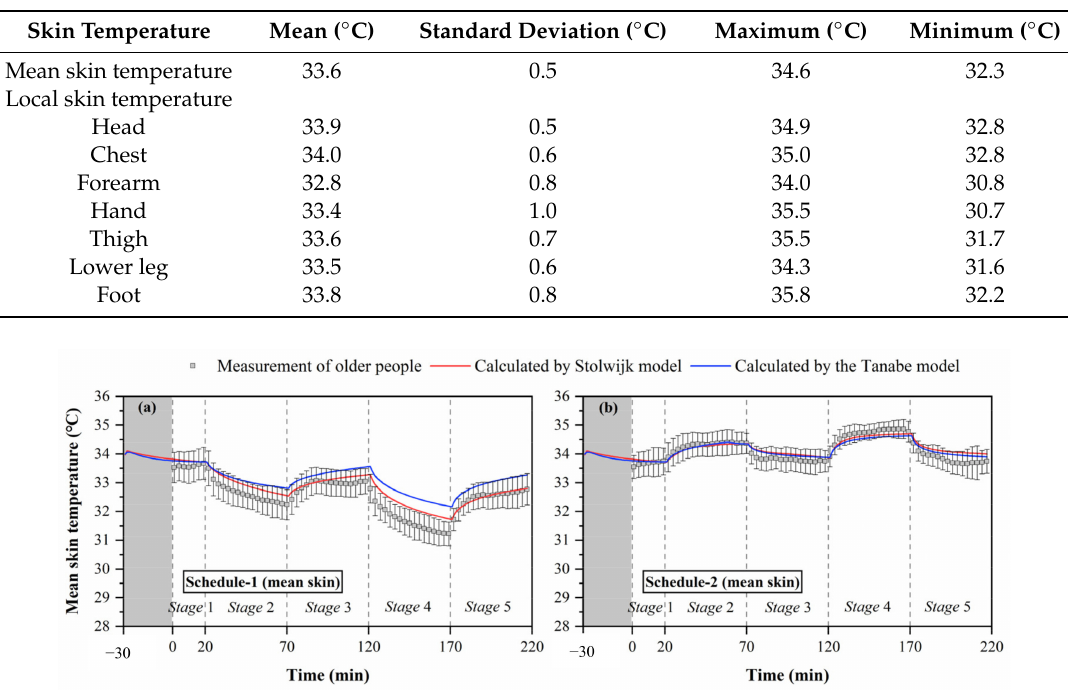
Figure 4. Mean skin temperatures measured by experiments and calculated by the Stolwijk model and Tanabe model, ( a ) schedule 1, ( b ) schedule 2.